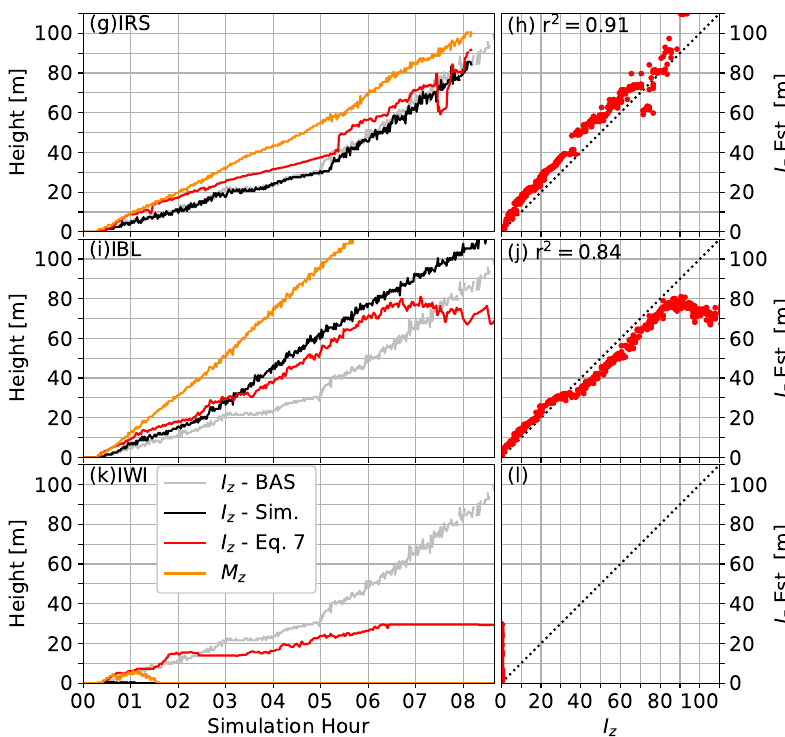
Figure A3. Estimated and simulated interface heights for the simulations in Table A2. ( a , c , e , g , i , k ) Time series of estimated and simulated fog depth, including the simulated depth from the BAS simulation (as in Figure 7a). ( b , d , f , h , j , l ) 1:1 comparison of estimated fog depth to simulated fog depth (as in Figure